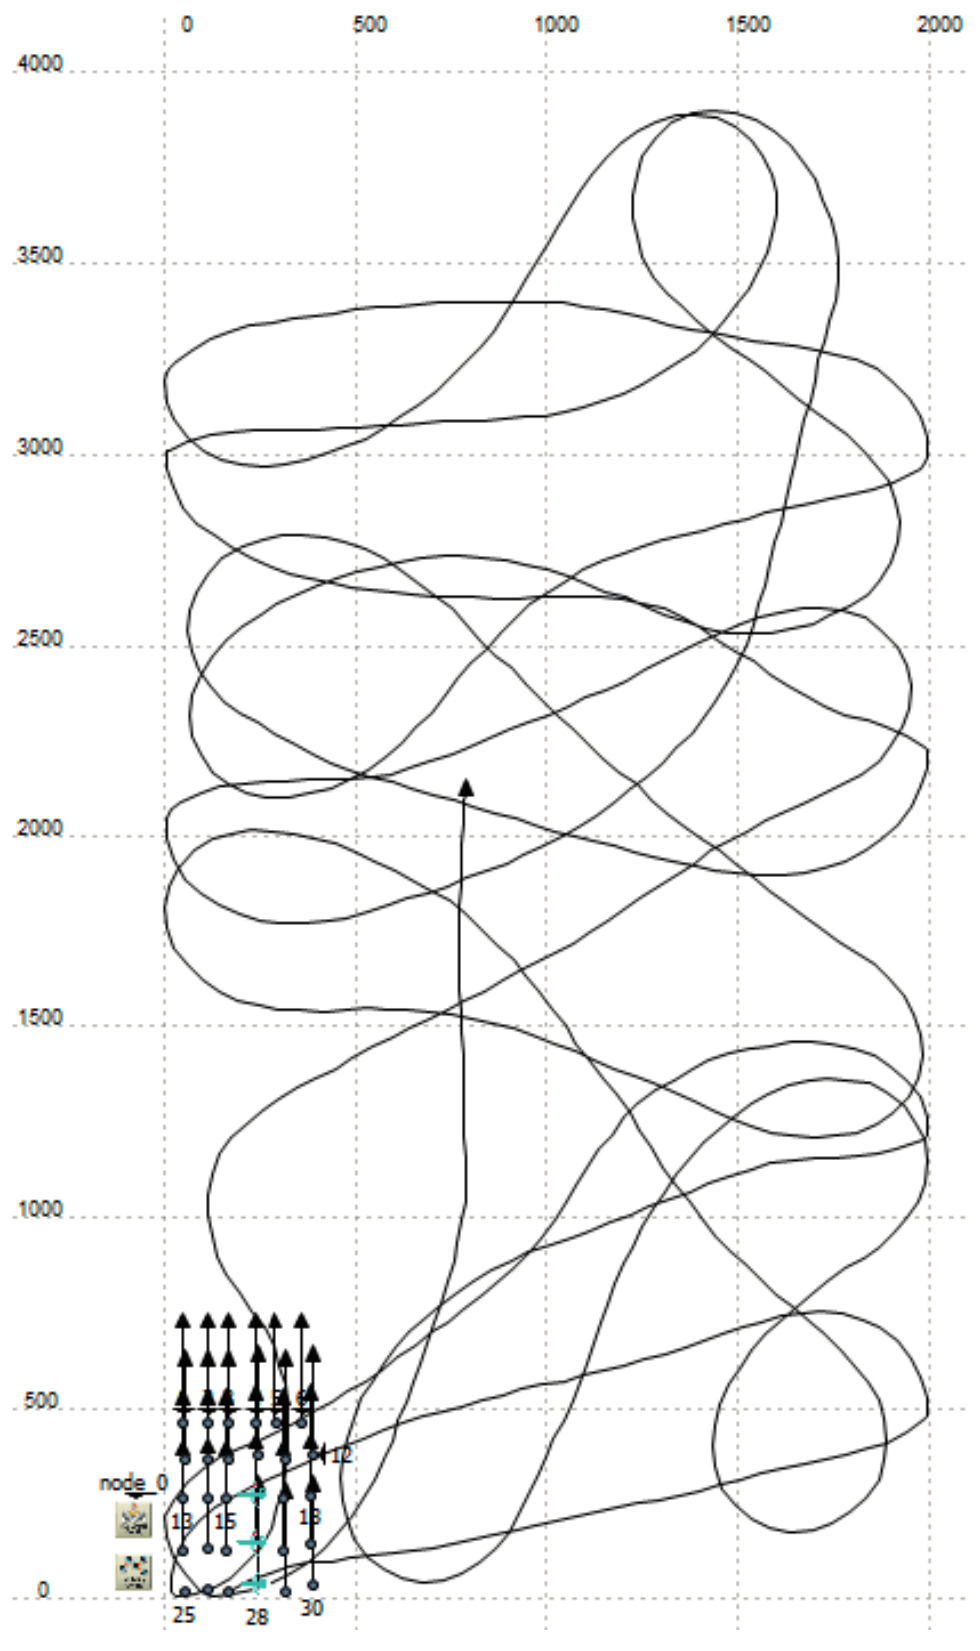
Figure 5. Trajectory of a UAV under the enhanced GM (EGM)